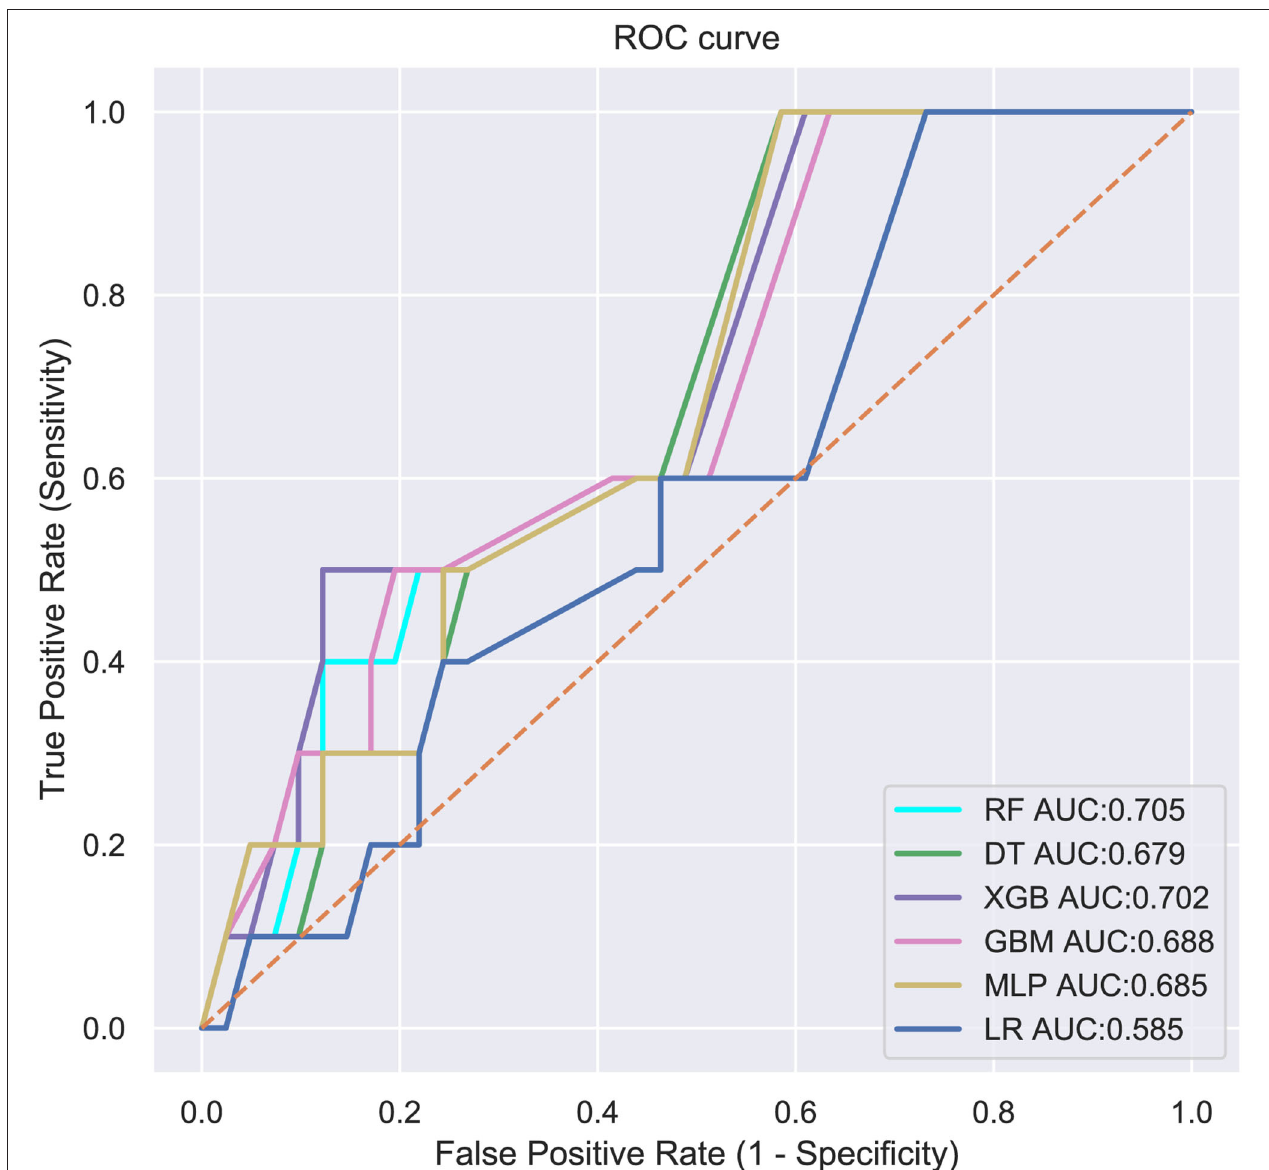
FIGURE 2 | External validation of machine learning algorithms. RF, Random Forest; DT, Decision tree; XGB, Extreme gradient boosting; GBM, Gradient boosting machine; MLP, Multilayer perceptron; LR, Logistic regression; AUC, area under the